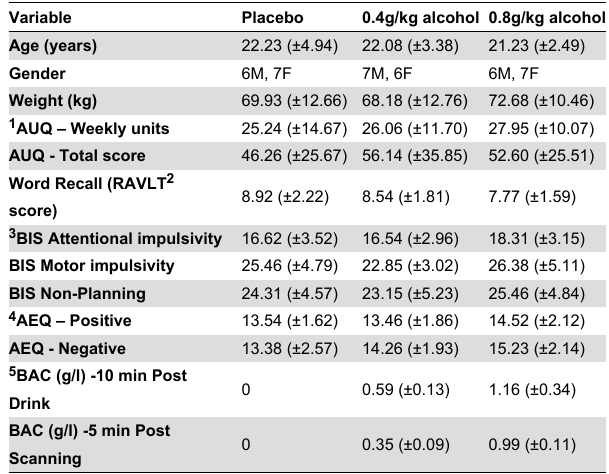
Table 1. Demographic information (age, gender, weight), Trait characteristics (AUQ 1 , AEQ 4 , BIS 3 and word recall), and BAC 5 measurements (post-drinking and post-scanning) presented separately for the placebo, the 0.4g/kg, and the 0.8g/kg alcohol-dose